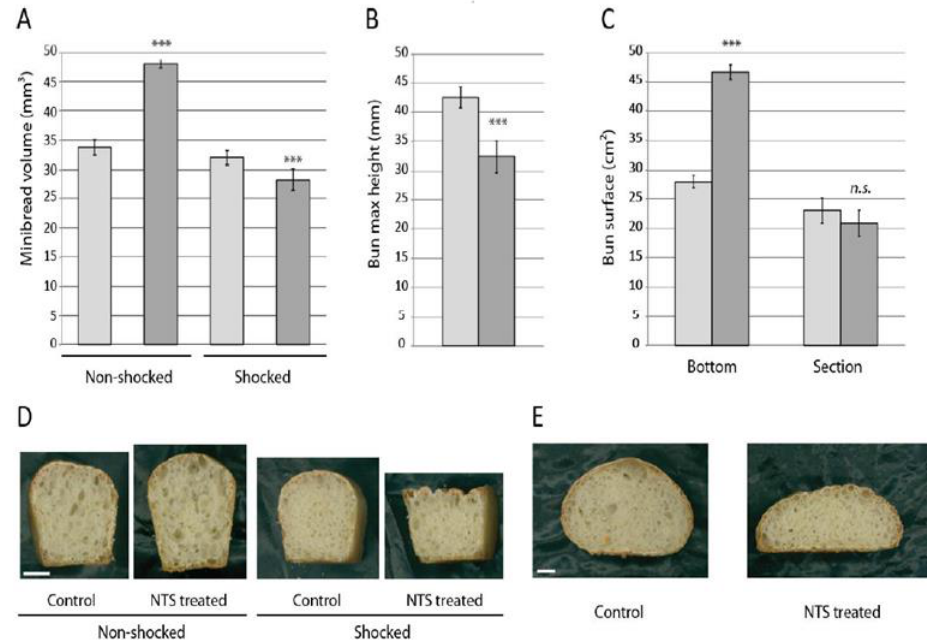
Figure 3. Shape parameters of buns and minibreads treated with NADPH and NTR. The average values for four buns or five minibreads ± standard error are shown. Control: light grey. NTS-treated samples: dark grey. ( A ) Bottom and cross-section surfaces of buns (cm 2 ). ( B ) Height of buns (mm). ( C ) Minibread volume (mm 3 ). ( D ) Cross-section photography of representative buns treated with phosphate buffer only (control) or 16 mg NADPH and 2 mg NTR in buffer (treated). ( E ) Cross-section photography of representative minibreads treated with phosphate buffer only (control) or 16 mg NADPH and 2 mg NTR in buffer (treated), with or without shock treatment. Asterisks indicate significant difference to control (Student t -test, p ≤ 0.01). Scale bar = 10 mm.